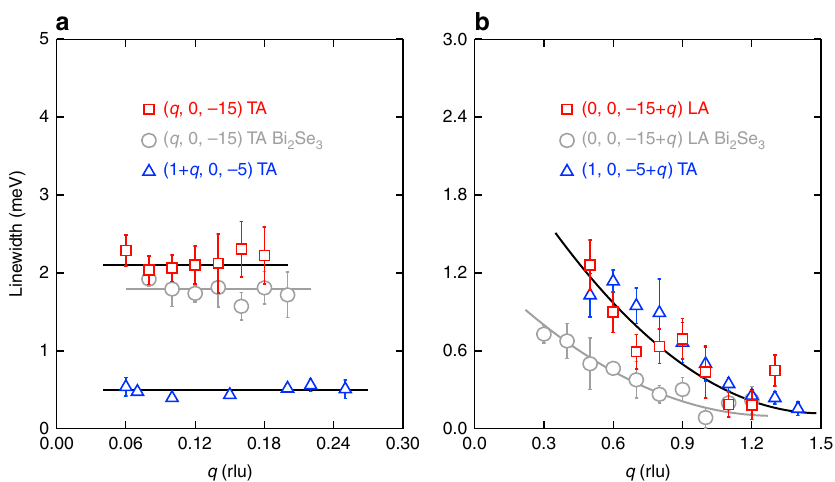
Fig. 4 Evolution of the phonon linewidth with q . a , b Phonons along the [100] and [001] directions, respectively. Squares and triangles represent results extracted from data collected on a TOF spectrometer AMATERAS and TAS PANDA, respectively. For comparison, the linewidths of the Bi 2 Se 3 phonons measured on AMATERAS are also plotted. Lines through data are guides to eye to illustrate the evolution of the phonon linewidth as a function of